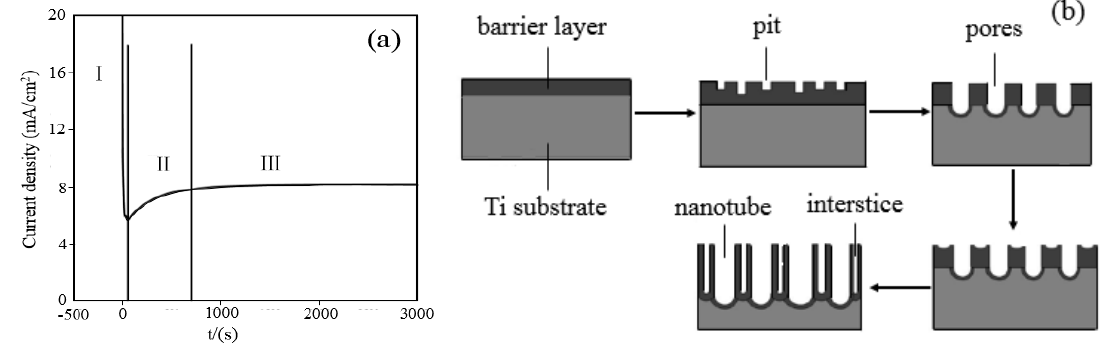
Figure 1. Schematic diagram of ( a ) current density-time curve of anodization [43], ( b ) TiO 2 nanotube formation mechanism [44].